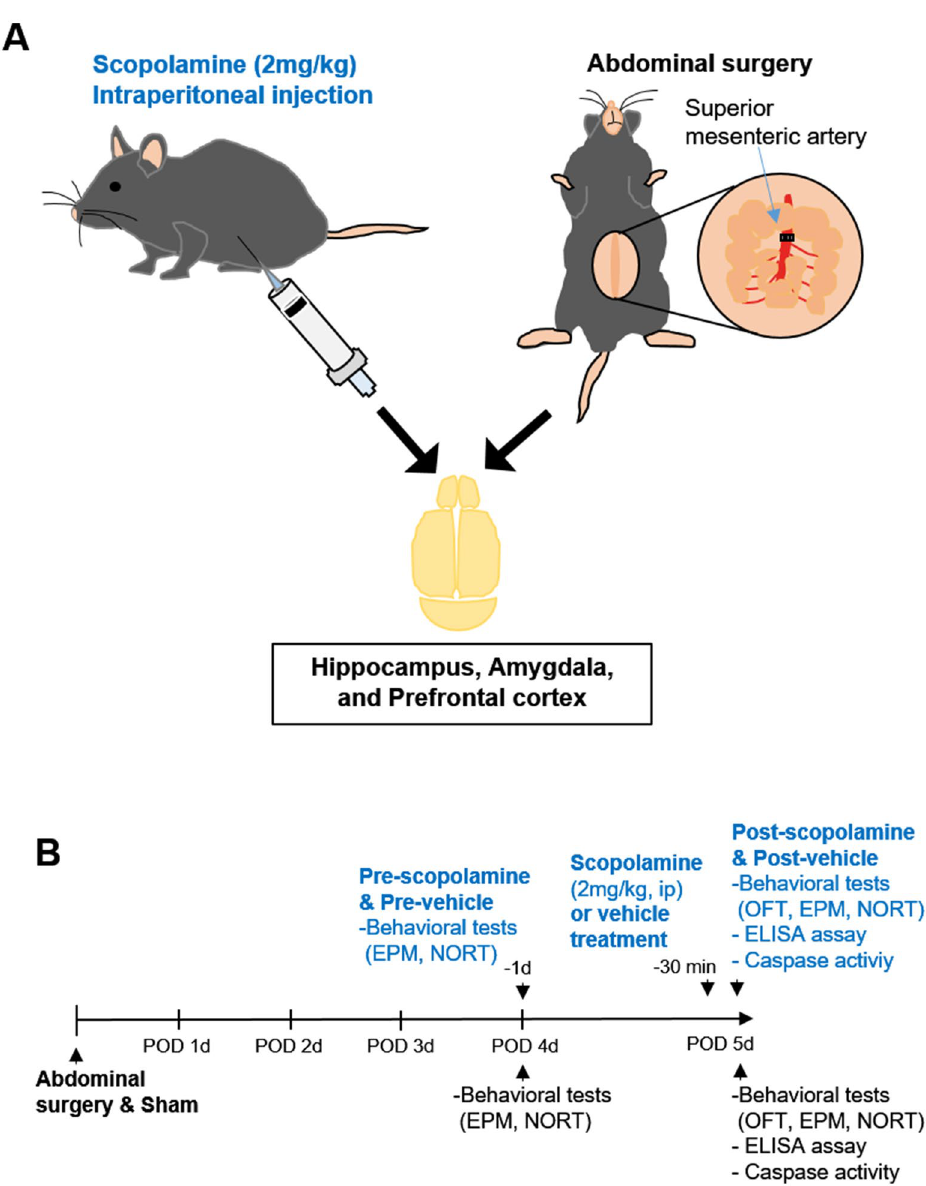
Figure 1. Experimental design and procedure. ( A ) Scopolamine (2 mg/kg) or vehicle was injected intraperitoneally. Mice were subjected to abdominal surgery by clipping superior mesenteric artery and rubbing intestines. All mouse brains were isolated, and brain sub-regions, such as hippocampus, prefrontal cortex, and amygdala, were analyzed after surgery or scopolamine treatment. ( B ) Mice in surgery group and sham group performed behavioral test at 4 and 5 day post-surgery. Mice in both vehicle and scopolamine-treated groups performed behavioral test at 1 day before scopolamine or vehicle treatment, and 30 min after scopolamine or vehicle